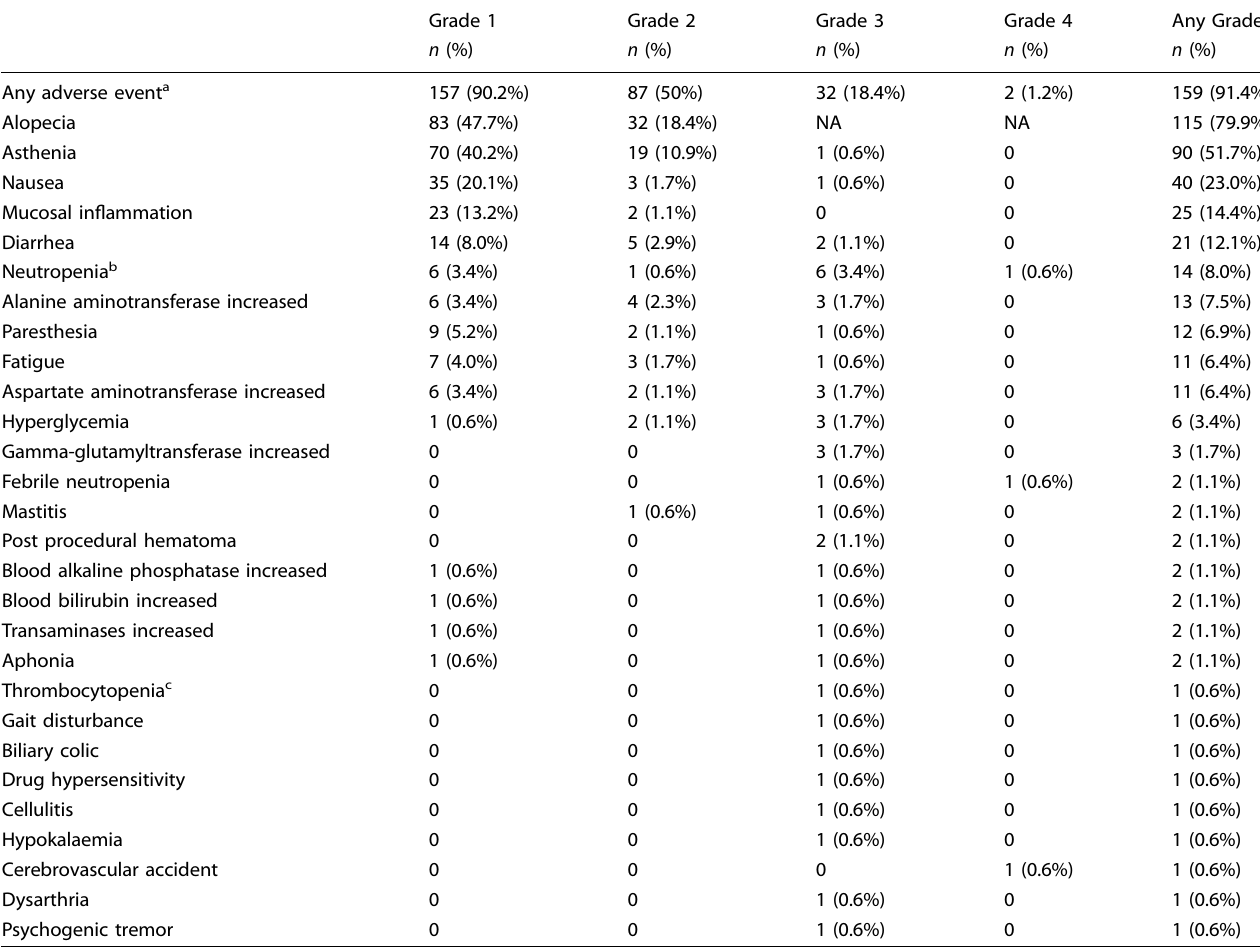
Table 3. Summary of adverse events regardless of relationship to study